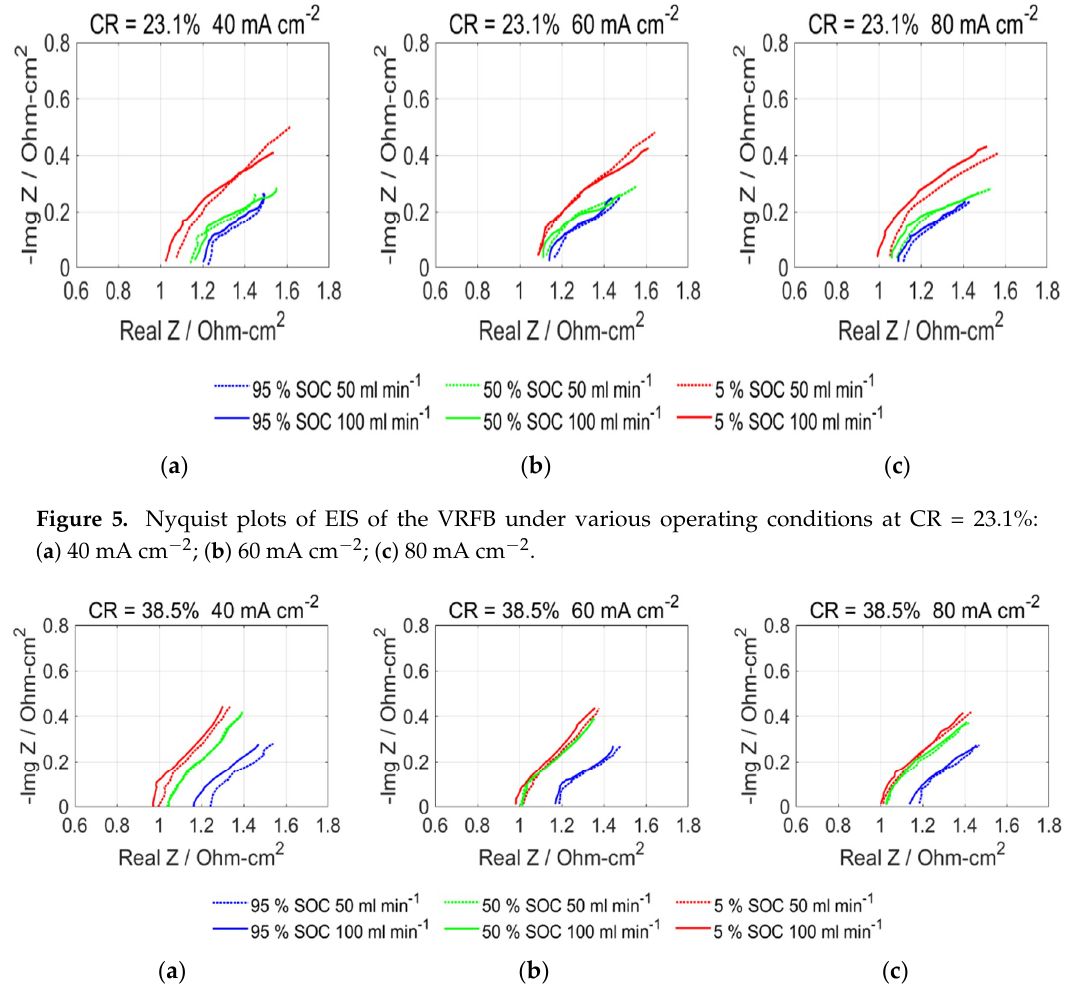
Figure 6. Nyquist plots of EIS of the VRFB under various operating conditions at CR = 38.5%: ( a ) 40 mA cm −2 ; ( b ) 60 mA cm −2 ; ( c ) 80 mA cm −2.